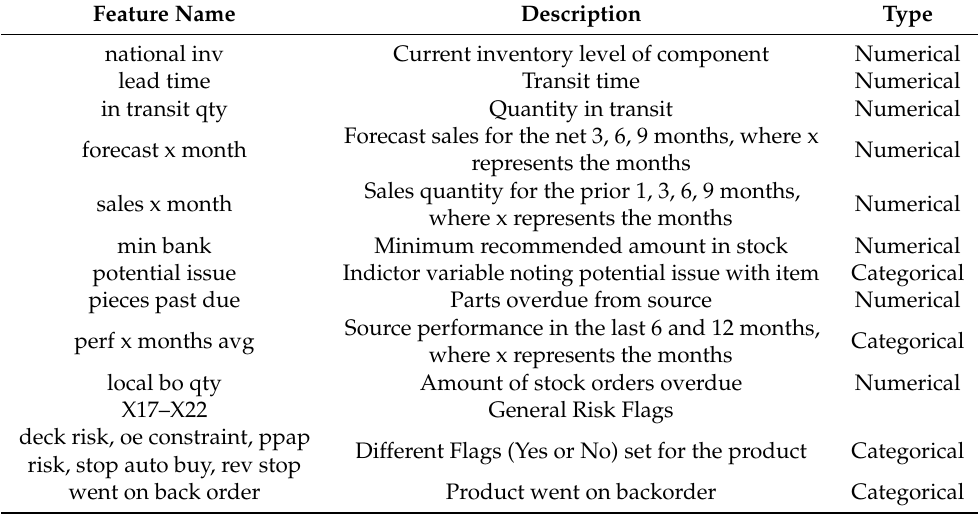
Table 1. Dataset description.